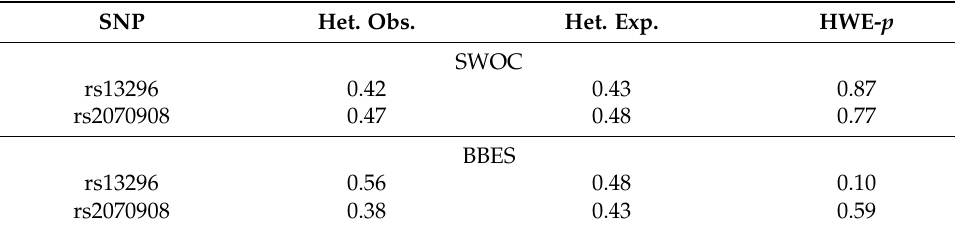
Table 3. Hardy-Weinberg equilibrium and frequency reported.